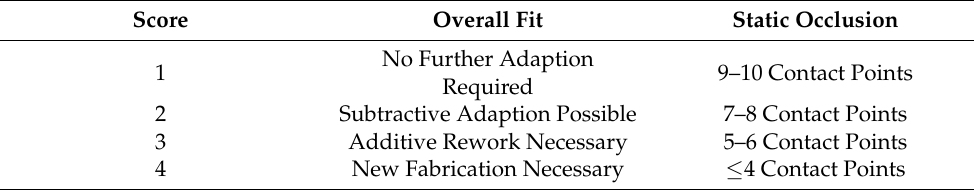
Table 1. Score system for the overall fit and static occlusion.